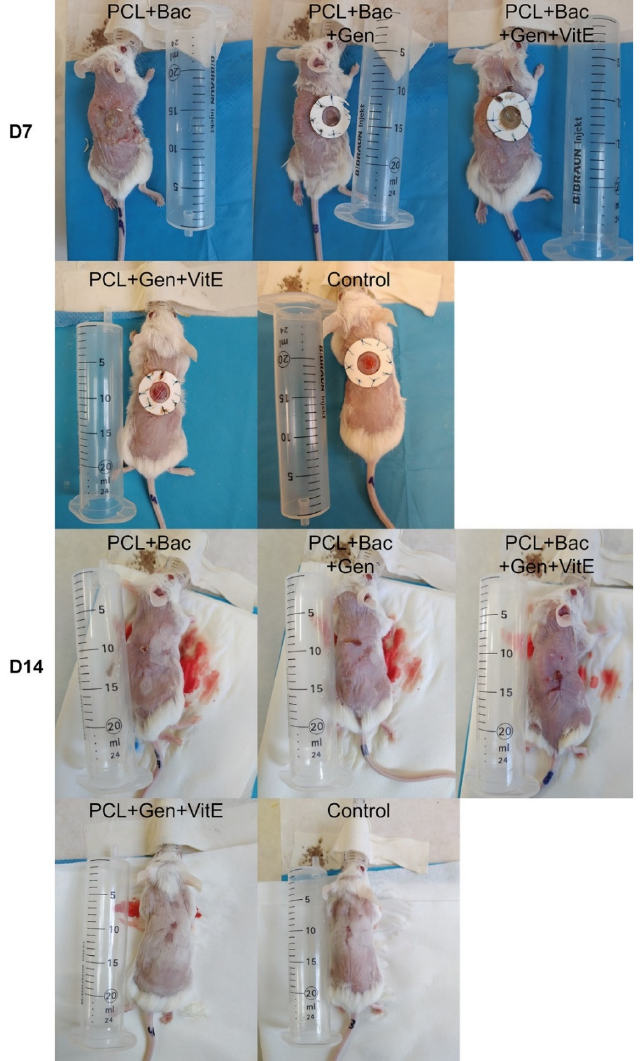
Figure 10. Skin defects of the mice treated with PCL nanofibers (PCL), gentamicin (Gen), α -tocopherol acetate (VitE), and infected by S. aureus and P. aeruginosa (Bac) or untreated defects (control) on day 7 and 14 after surgery.